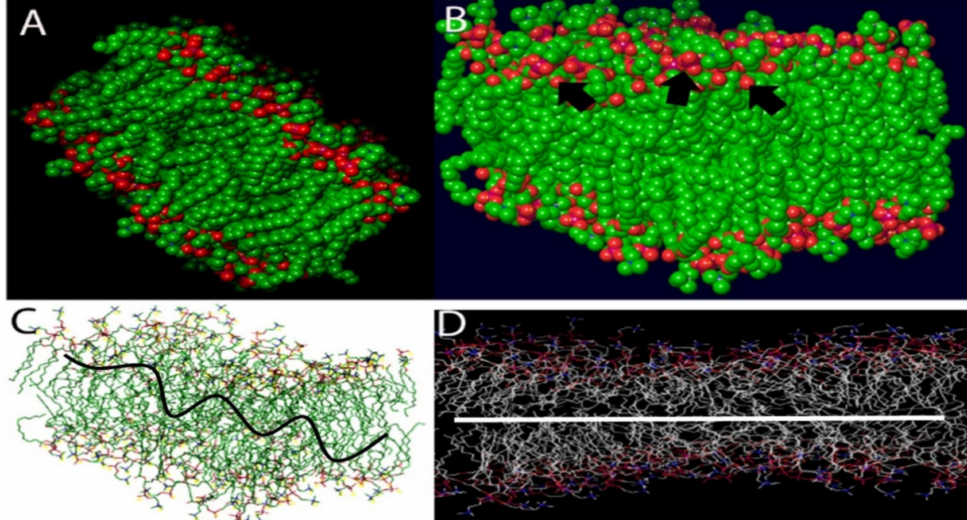
Figure 1. The distribution of proteins on the surface of the COVID-19 virus aligned by a random algorithm ( A – D ) was created with the Induced-Fit docking modules of Schrodinger 2019-4. The lipid system was generated to produce a random and organic